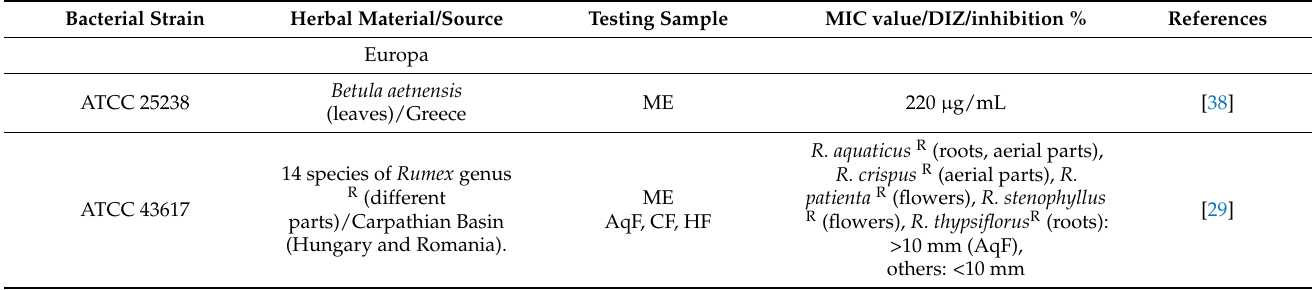
Table 5. Medicinal plants tested for the antimicrobial effect against Moraxella catarrhalis